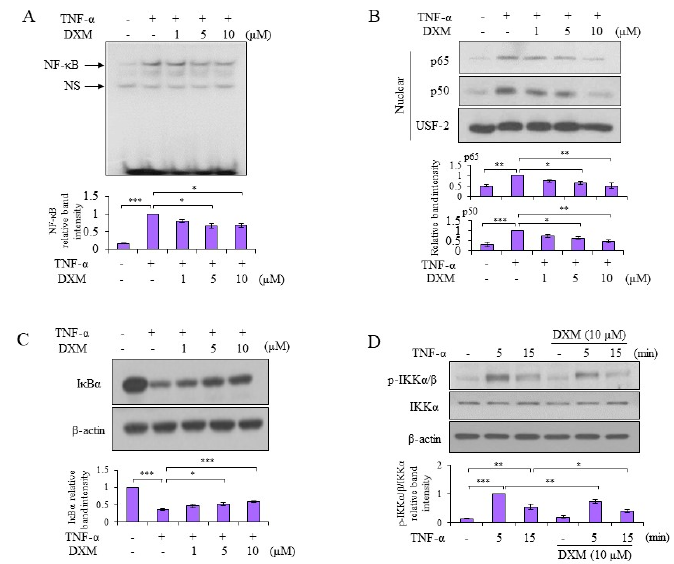
Figure 3. DXM suppressed TNF- α -induced nuclear factor-kappaB (NF- κ B) signaling. ( A ) Porcine chondrocytes were treated with TNF- α (5 ng/mL) and various doses of DXM. Collected nuclear extracts were determined for DNA-binding activity of NF- κ B by electrophoretic mobility shift assay (EMSA). ( B , C ) Porcine chondrocytes were pretreated with various doses of DXM for 2 h and then stimulated with TNF- α for 15 min. The nuclear extracts ( B ) and total cell lysates ( C ) were analyzed with Western blots. ( D ) Similar to ( C ), porcine chondrocytes were pretreated with 10 μ M DXM for 2 h and then stimulated with TNF- α for 5 or 15 min. Total cell lysates were analyzed by Western blots. The results included a pool of at least three independent experiments from different donors and are shown as fold induction compared to the TNF- α -stimulated sample. Values are the means ± S.E.M. and significance (* p < 0.05; ** p < 0.01; *** p < 0.001) was analyzed by one-way ANOVA or Student’s t -test. NS: non-specific.